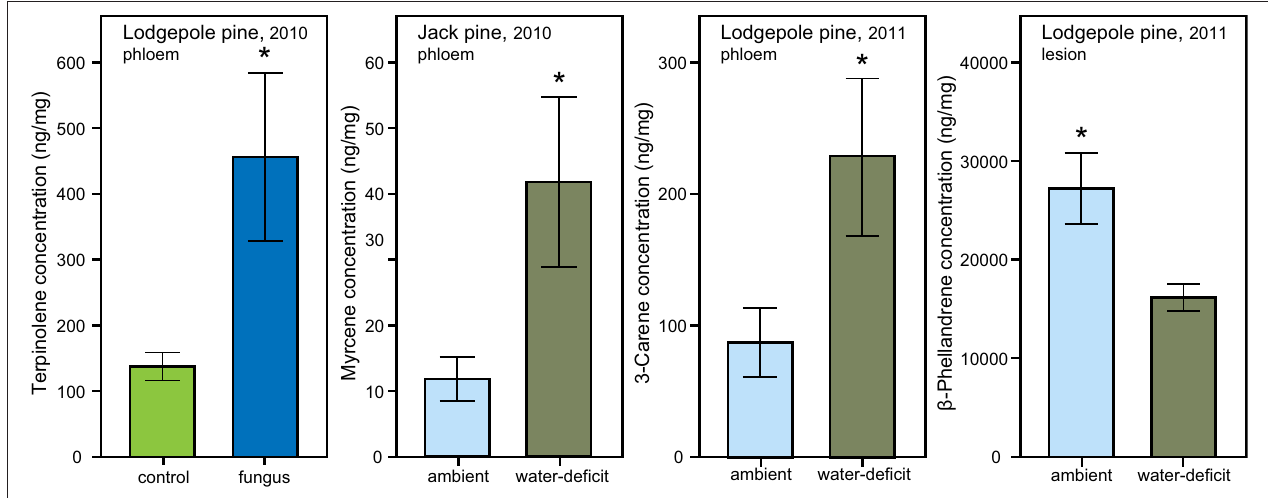
FIGURE 5 | Individual monoterpene concentrations (mean ± S.E.) in phloem and lesion tissue of lodgepole ( P. contorta ) and jack pine ( P. banksiana ) influenced by water- and biological treatment. Significant differences are marked with an asterisk (independent t -test, P < 0.05 ).